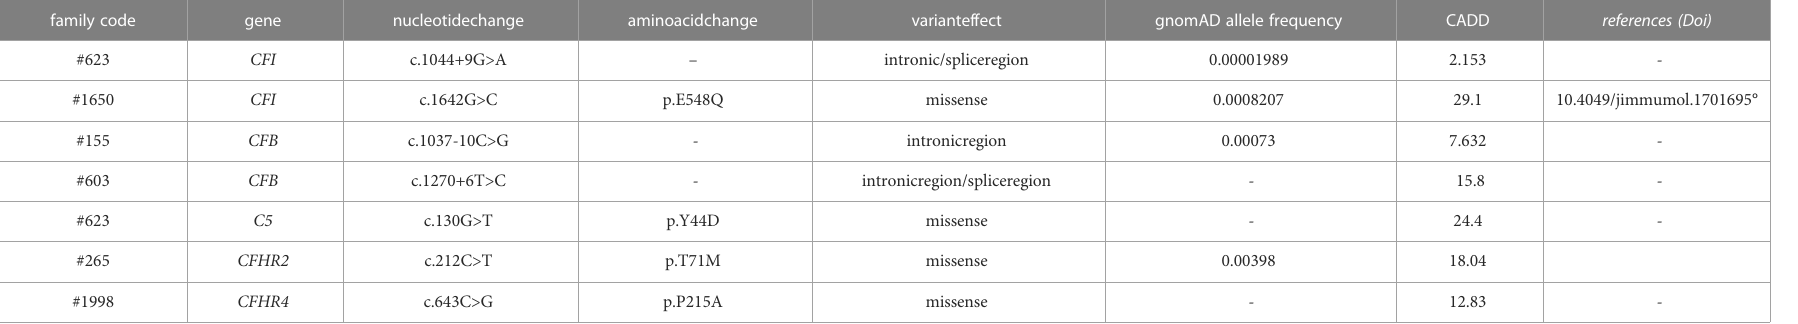
TABLE 2B List of rare complement gene variants identi fi ed in unaffected aHUS relatives but not in